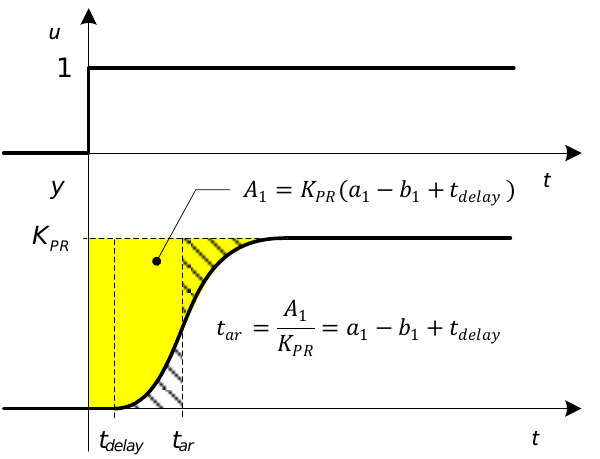
Figure 6. The average residence time t ar can be determined from the process open-loop response by means of integrating the yellow area or by estimating the position of the vertical line t ar so that the shaded areas are equal.